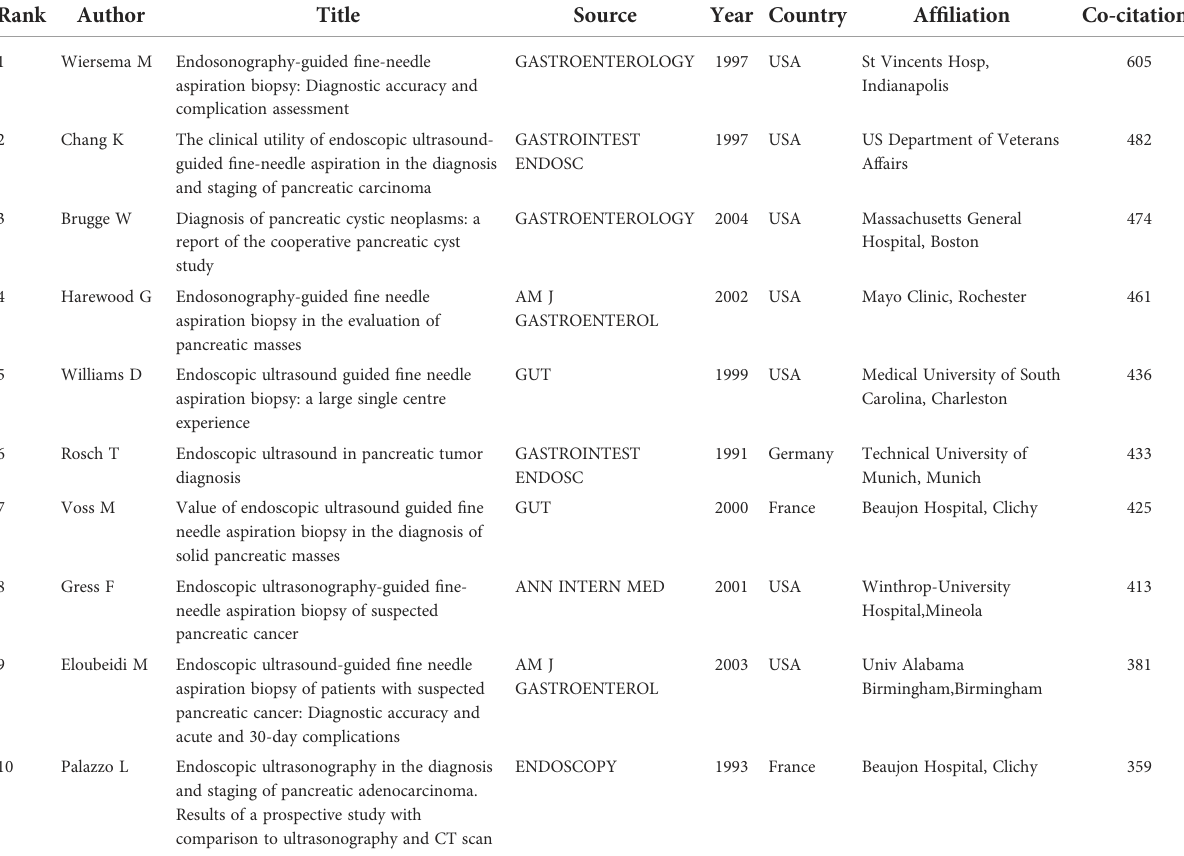
TABLE 2 Top 10 co-citation analysis of cited